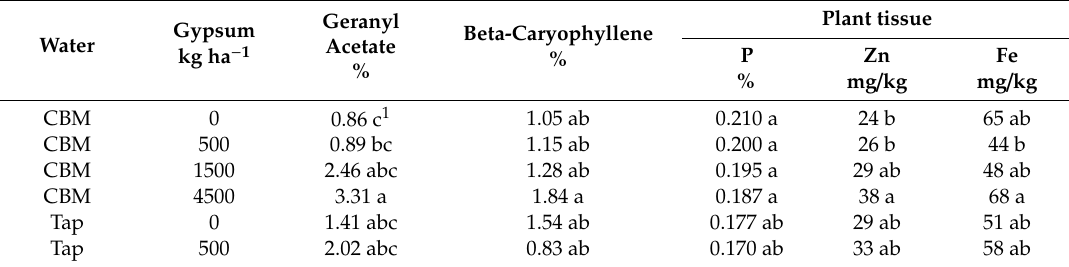
Table 8. Mean content of Geranyl Acetate and Beta-Caryophyllene in lemongrass essential oil and mean nutrient content of plant tissue from distillation waste [phosphorus (P), zinc (Zn), and iron (Fe)] obtained from the eight combinations of water (coal-bed methane and tap) and Gypsum applications in the lemongrass